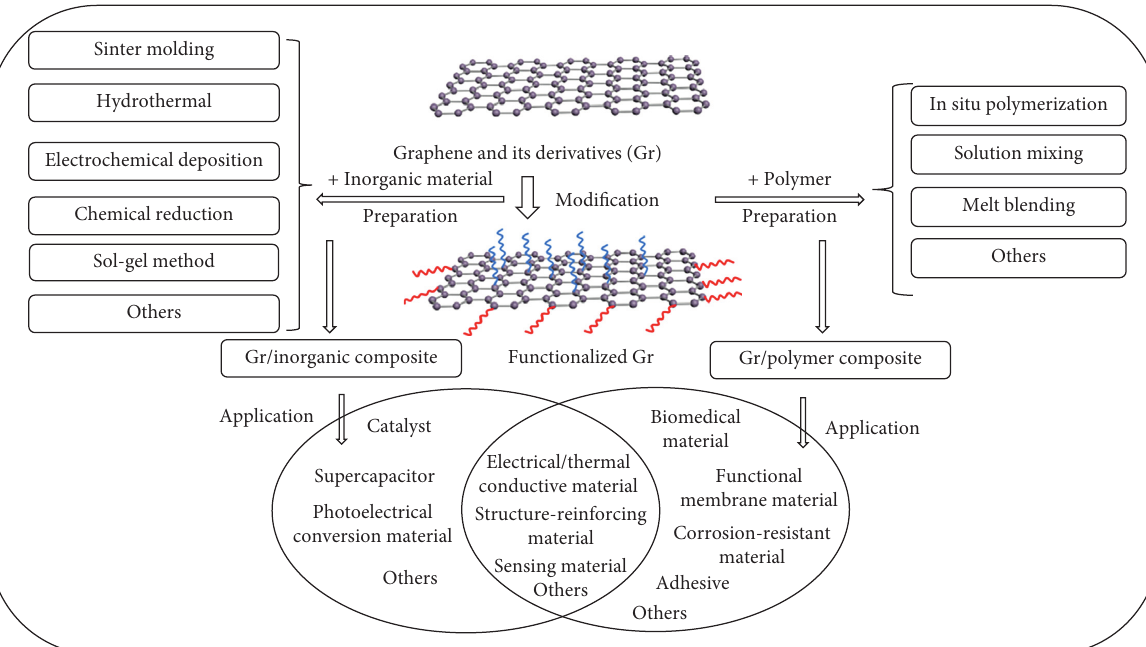
Figure 1: Covalent and noncovalent functionalization of graphene and its derivatives.